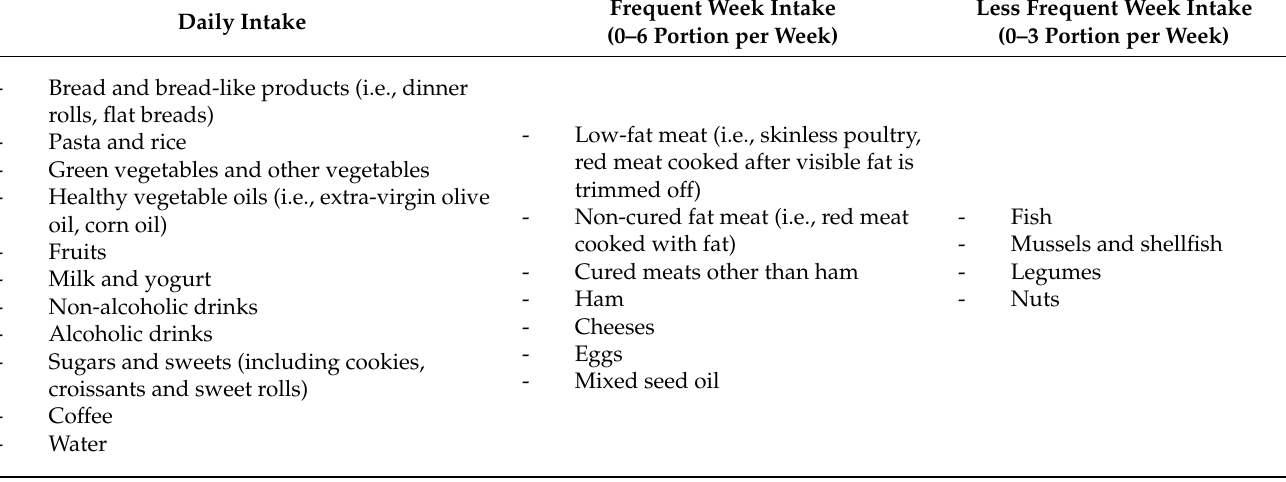
Figure 1. Flow-chart resuming the selection criteria for the sub-study analysis. Table 1. Investigated food categories by intake frequency.